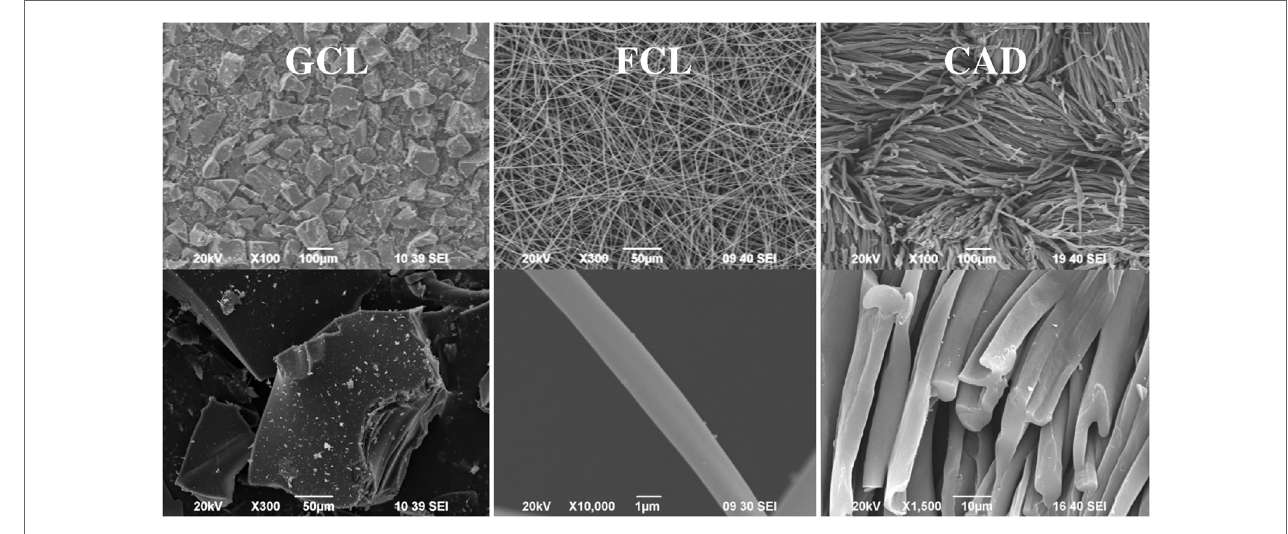
FigUre 1 | seM micrographs of gcl, Fcl, and caD